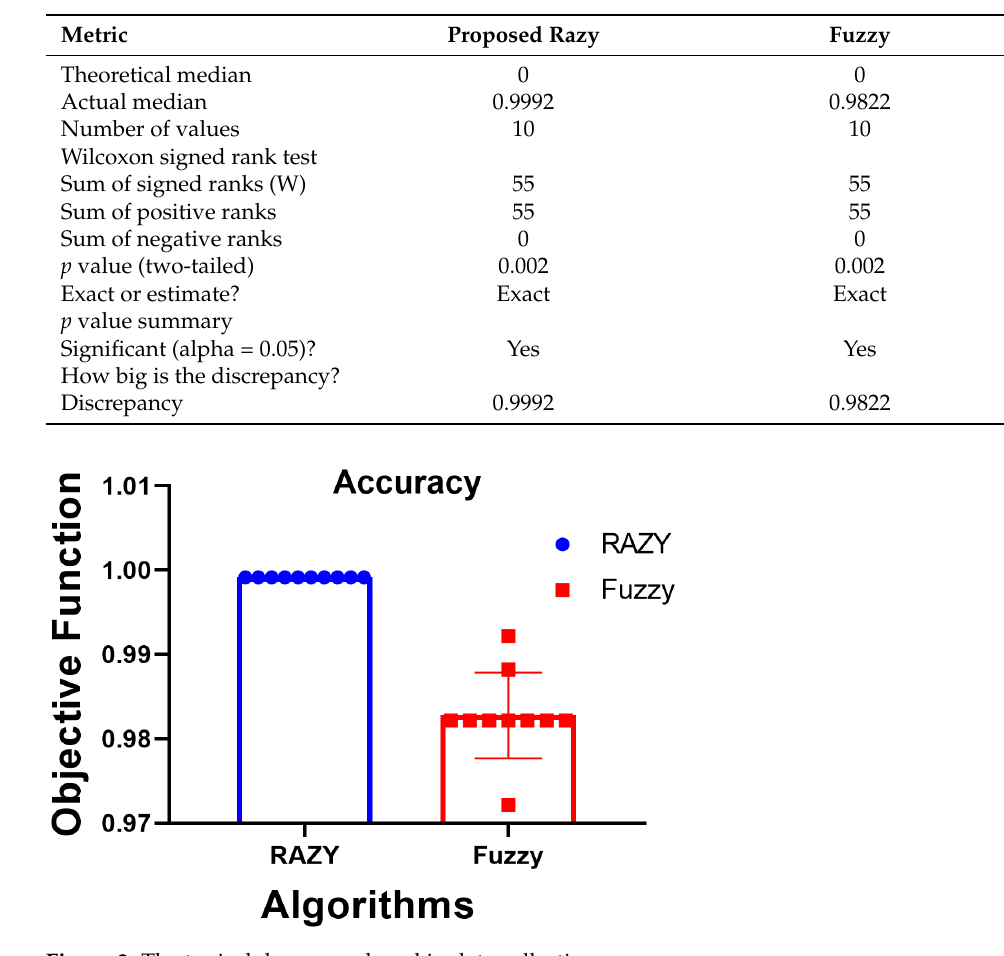
Figure 2. The typical drone employed in data collection.